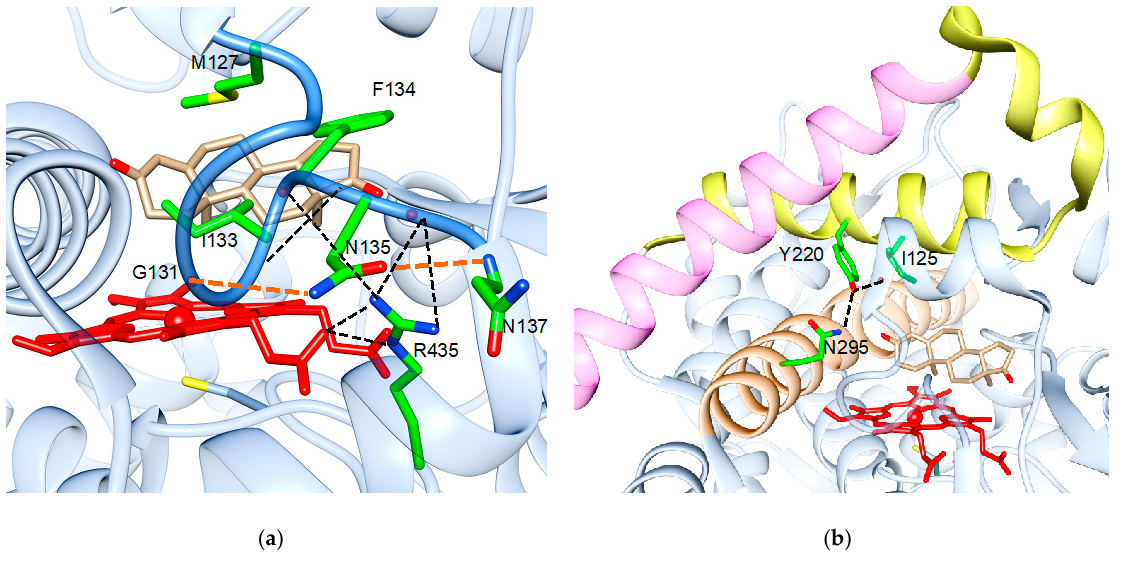
Figure 2. Role of the highly conserved residues in human aromatase (PDB ID 4KQ8). ( a ) Involvement of the highly conserved N135 in bridging G131 and N137 via H-bonds (shown in orange), which is important to maintain the B-C loop (blue) conformation and provide M127 and F134 to the active site of the protein. The H-bond network is shown in black. ( b ) Involvement of the highly conserved Y220 in H-bonds that connect N295 and I125. N295 is part of SRS-4, shown in orange, Y220 is part of SRS-2, shown in yellow, and SRS-3 is shown in magenta. SRS-2 is highly variable in P450s, and it carries conserved residues in aromatase.